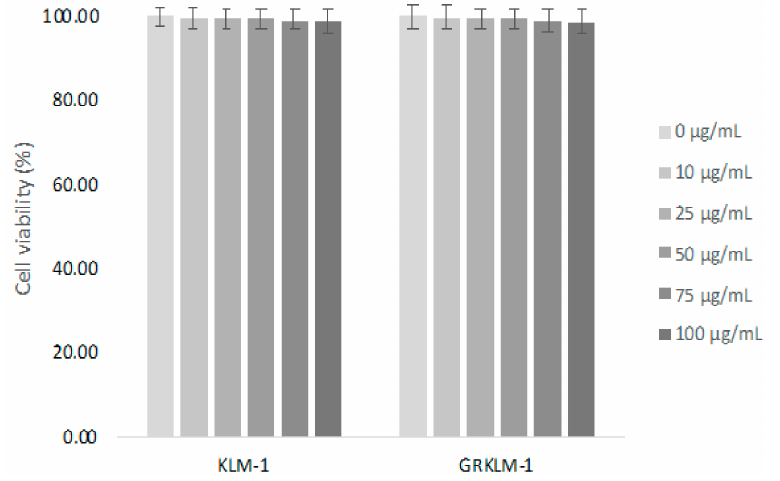
Figure 5. Biocompatibility studies of magnetic-plasmonic nanoparticles of various concentrations in KLM-1 and GR-KLM-1 cell